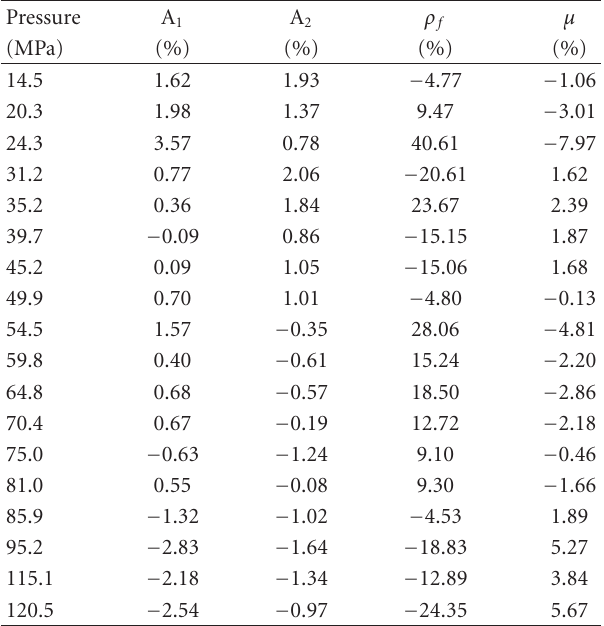
Table 5: Errors in coe ffi cient A and evaluated properties for n-